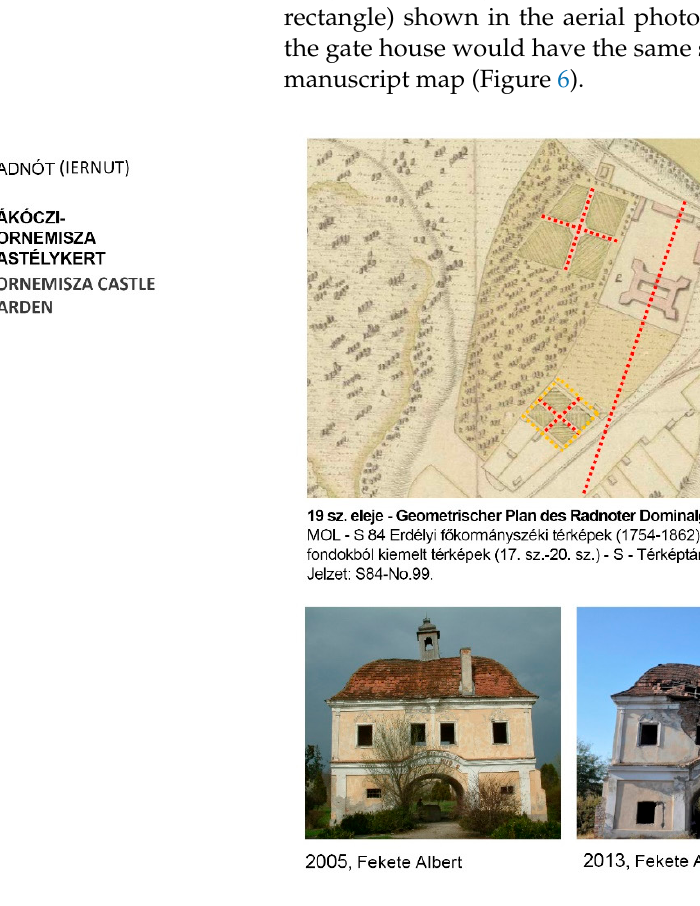
Figure 6. Historic analysis of the surroundings of the princely castle in Radnót (Iernut, RO).